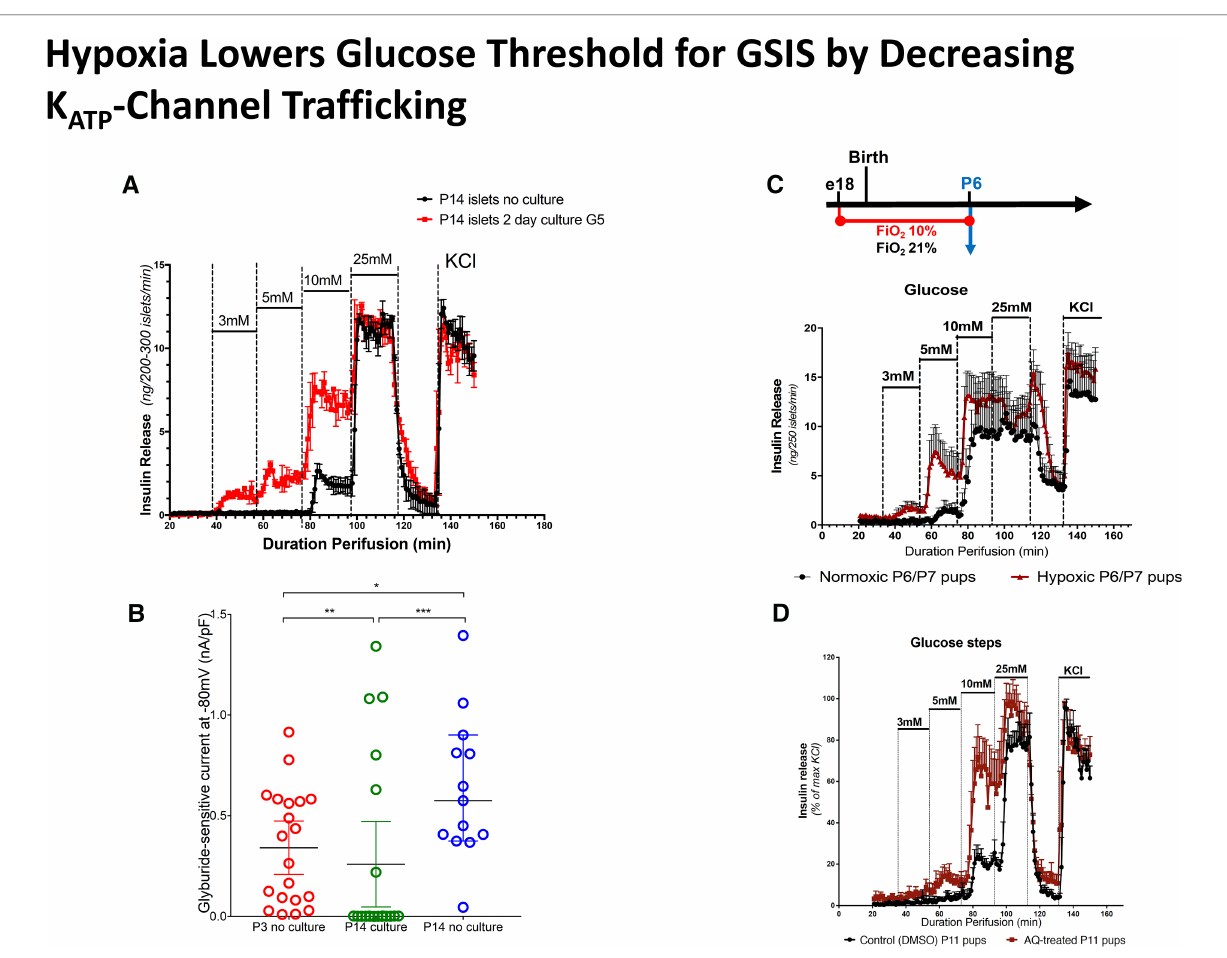
FIGURE 7 Hypoxia lowers glucose threshold for insulin release by decreasing K ATP -channel traf fi cking. ( A ) Hypoxia induced by culture of isolated islets for 2 days lowers the glucose threshold for glucose stimulated insulin secretion (GSIS). ( B ) Islet culture for 2 days reduces K ATP -channel traf fi cking compared to P14 islets without culture, similar to P3 islets without culture. ( C ). Exposure to hypoxia (FiO2 10%) from embryonic day E18 until postnatal day P6 reduces glucose threshold for GSIS. ( D ) Adaptaquin (AQ) treatment to mimick hypoxia by stabilizing Hypoxia Inducible Factor (HIF) lowers glucose threshold for insulin release in P11